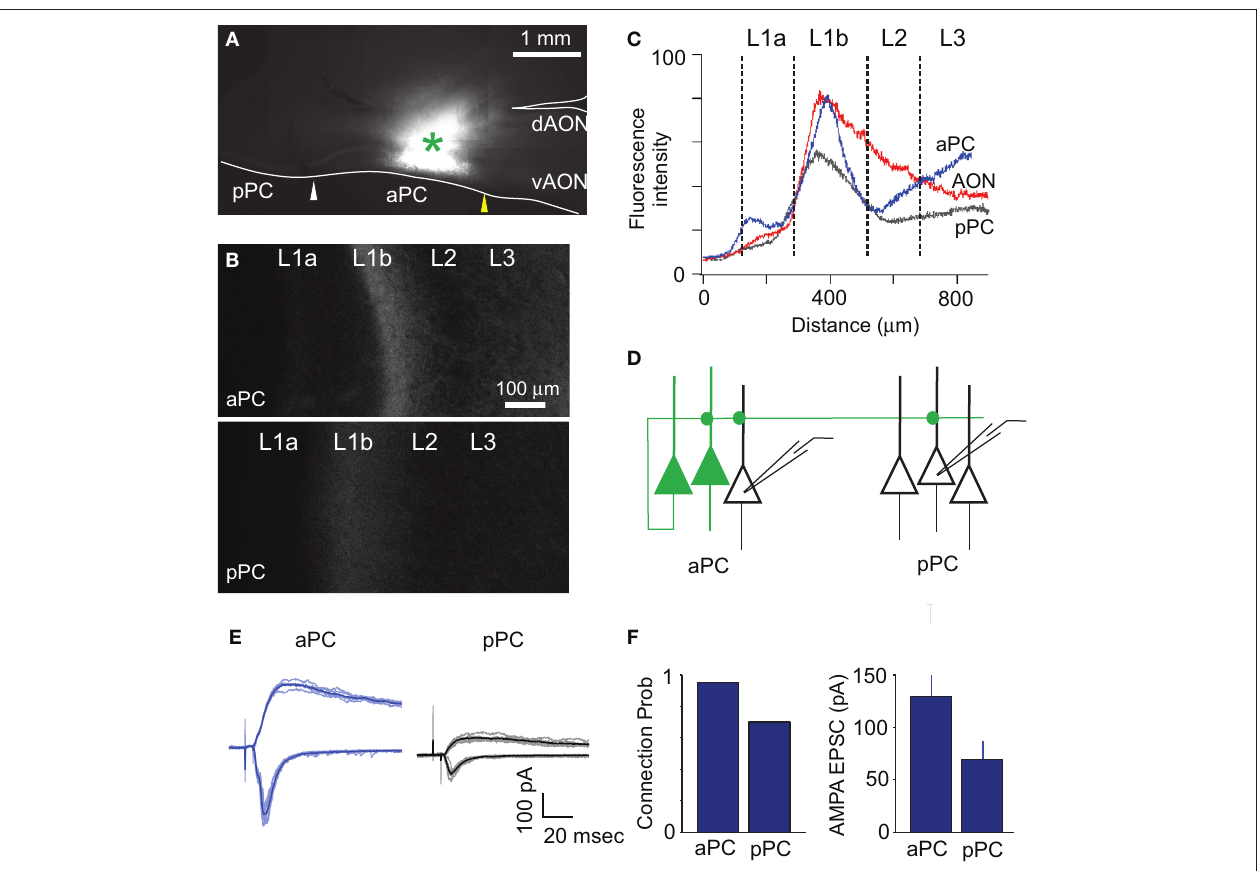
the aPC and pPC. (D) Schematics of intrinsic connection in the PC. (E) In the aPC and pPC, a 5ms LED flash induced synaptic EPSCs due to activation of ChR2 in presynaptic terminals. Whole-cell patch-clamp recording from neurons demonstrated AMPA receptor-mediated inward current at − 70mV and outward current through the AMPA and NMDA receptors at + 40mV. (F) Probability of synaptic responses was almost 100% in the aPC, and that in pPC was only reduced to 93.3%. Amplitude of AMPA EPSCs was lower in pPC (69.3 ± 16 pA) than in aPC (129 ±